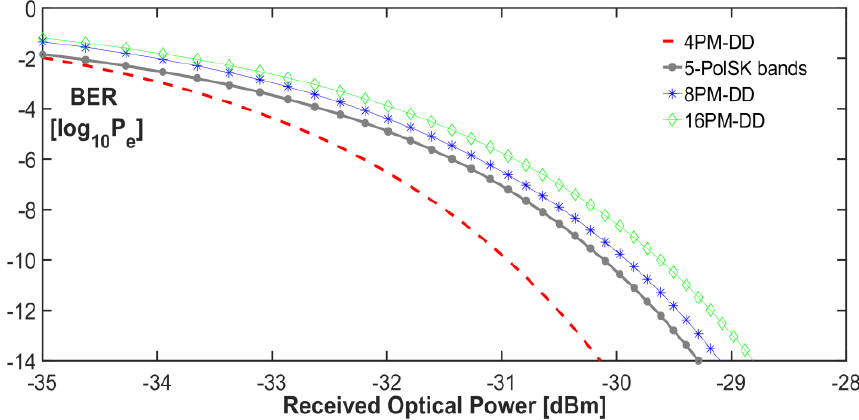
Figure 12. Comparison between Polarization Modulated Direct Detection (PM-DD) [14] and 5-PolSK.